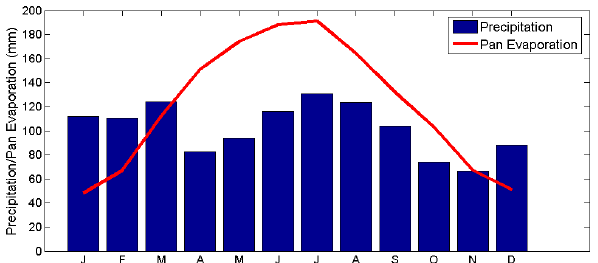
Figure 2. Average monthly precipitation and monthly pan evapora- tion for the study area (data from Kilgo and Blake,